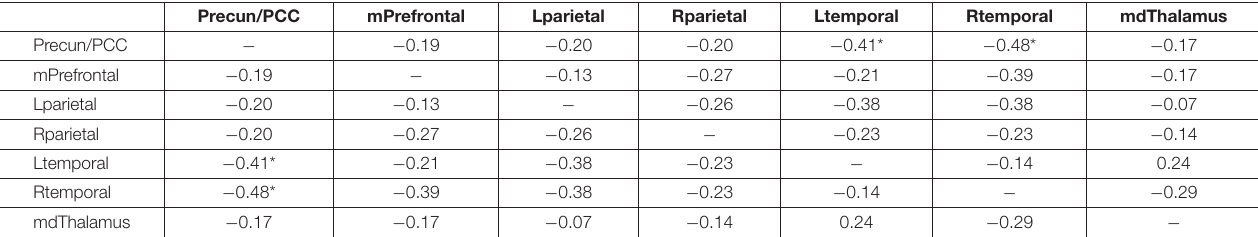
TABLE 3 | Node-specific correlation values of DMN connectivity change and nicotine